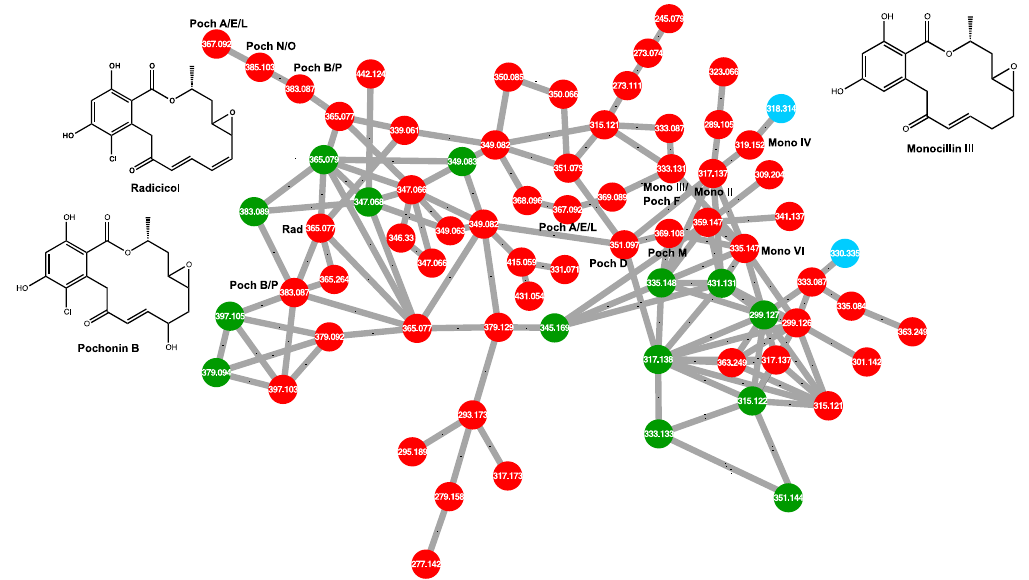
Figure 3. Close-up of the GNPS molecular network cluster containing radicicol and related compounds. m / z values are labeled on nodes, and putative compound identifications are assigned where applicable. Structures are included for compounds from Table 1 that are found within this cluster. (Poch—pochonin; Mono—monocillin; Rad—radicicol) .